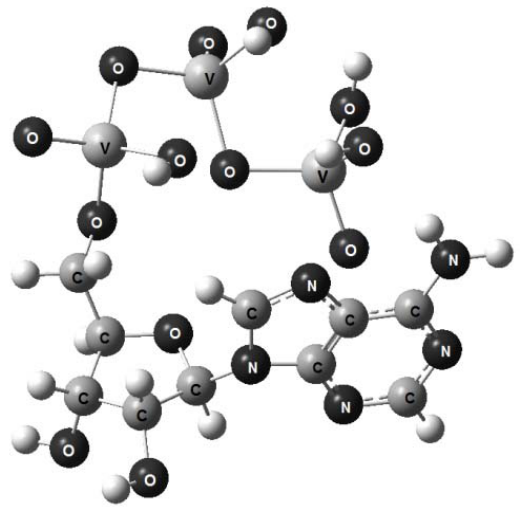
Figure 4. A stereoview of the model representing vanadium-containing protonated form, ATV.